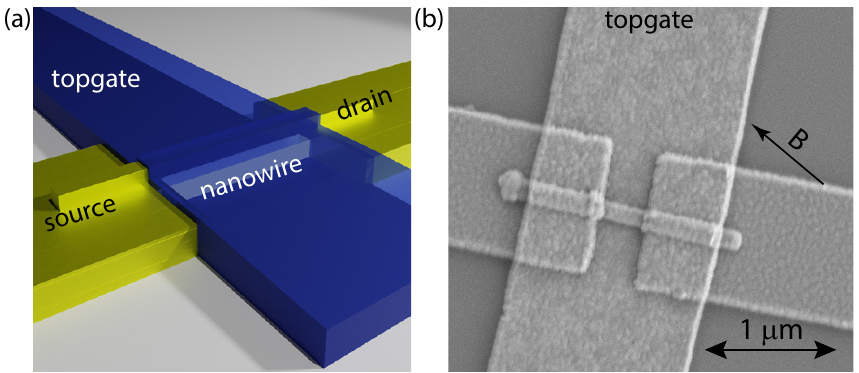
Figure 1: a Model of a topgate device. Contacts are colored with gold, top gate is represented by transparent blue. b SEM image of typical device (device 9). The orientation of magnetic field B corresponds to device 1 studied in Figs. 2 and